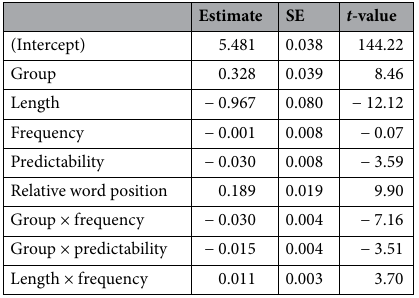
Table 1. Fixed effects, standard errors (SE) and corresponding test statistics of the LMM on participants’ gaze duration.